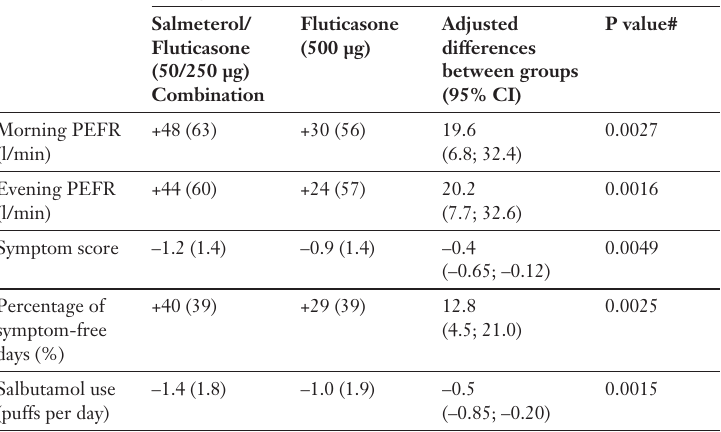
Change in morning and evening peak expiratory flow rates, asthma symptoms, and use of rescue medication after 6 and 12 weeks of study medication in comparison to base-line at randomisation (means, standard deviations), and adjusted differences between groups (95% confidence intervals). The results are from analysis of co-variance with treatment as experimental factor and baseline values, age, sex, height, duration of preceding treatment with inhaled corticosteroids shorter than two years (yes/ no), fluticasone medication prior to the study (yes/no), and MEF 50 less than 50% of predicted (yes/no) as